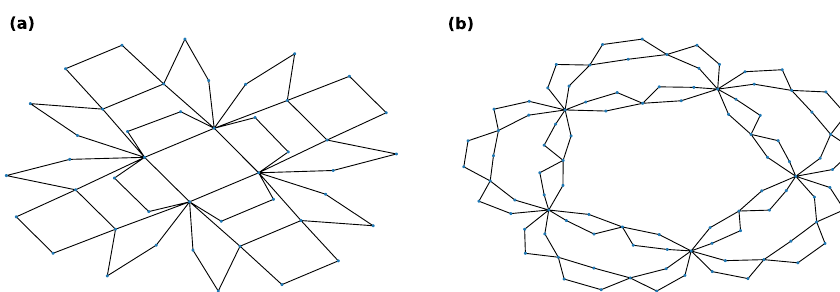
Fig. 6 Illustration of the ( u , v )‑flower with three iteration steps and a u = 1, v = 3 , b u = 2, v = 3